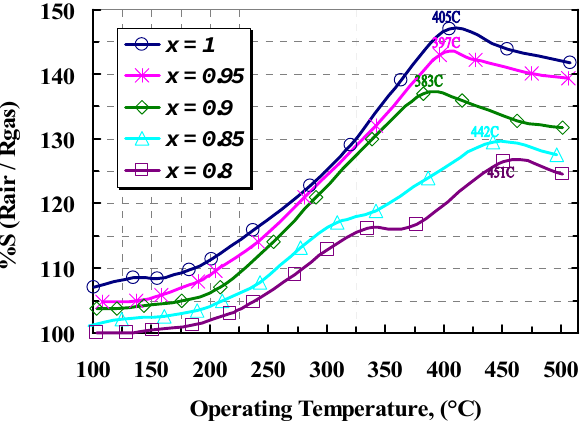
sensor to 1,000 ppm methane versus operating